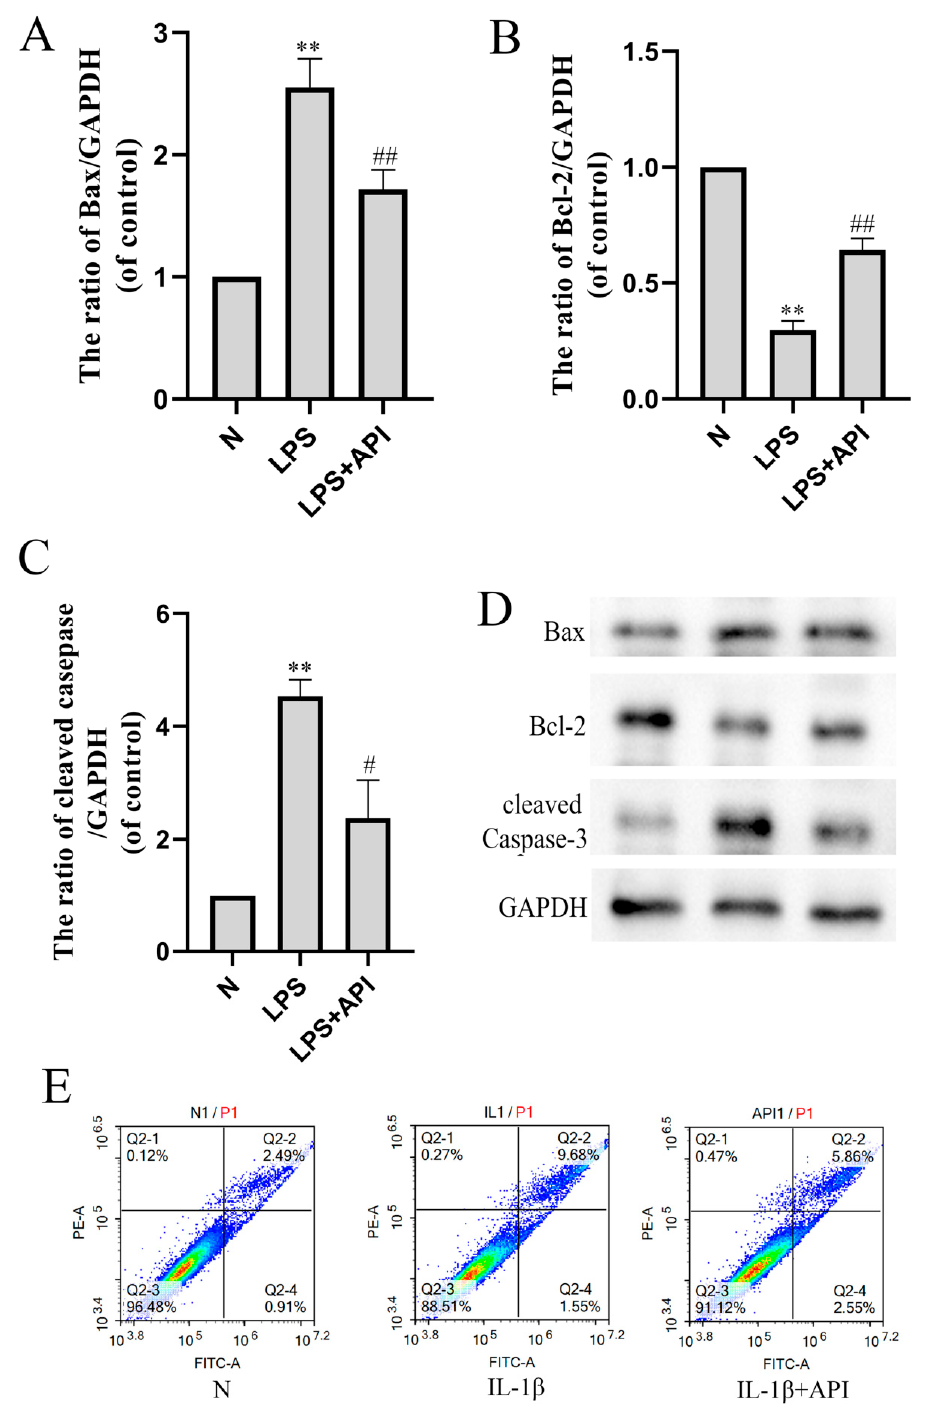
Figure 9. The effect of apigenin on chondrocyte apoptosis in the macrophage–chondrocyte co- culture system. ( A ) Bax protein level; ( B ) Bcl-2 protein level; ( C ) cleaved-caspase3 protein level; ( D ) Representative Western blotting images of Bax, Bcl-2, and cleaved-caspase3; ( E ) Flow cytometry of chondrocytes in the macrophage–chondrocyte coculture model. In the two-color flow cytometry scatter plot, the Annexin V-FITC is represented on the X axis and the PI is represented on the Y axis. Living cells were double negative (Annexin V-FITC-/PI-), early apoptotic cells were Annexin V-FITC+/PI- positive (Annexin V-FITC+/PI-), late apoptotic cells were Annexin V-FITC and PI positive (Annexin V-FITC+/PI+). Data are the mean ± SD of the mean. ** p < 0.01 versus normal group (N); # p < 0.05 versus LPS group; ## p < 0.01 versus LPS